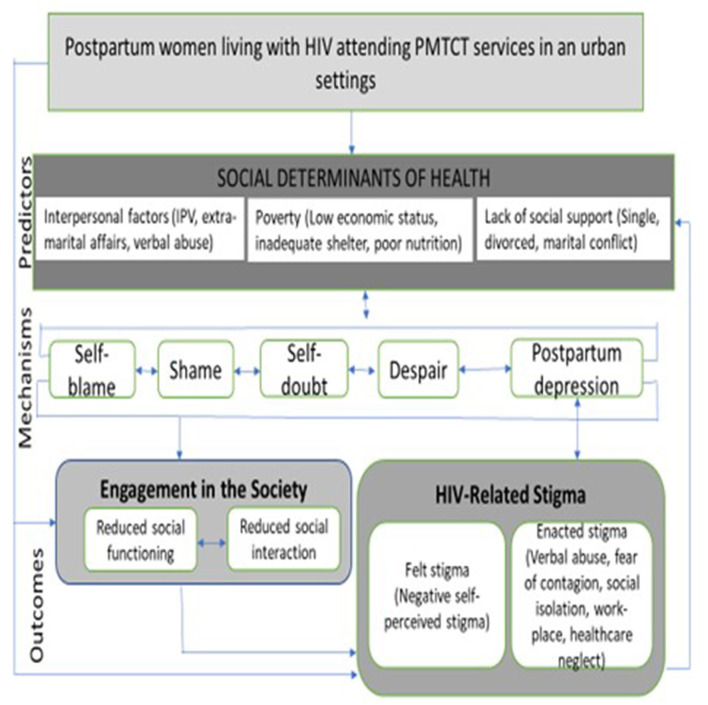
Conceptual framework for HIV-related stigma (Adapted from (32)).